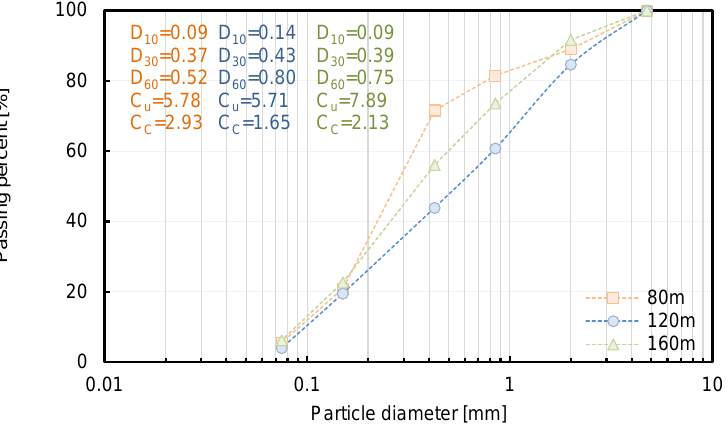
Figure 2. Results of sieve analysis. The D 10 , D 30 , and D 60 denote the particle diameter corresponding to 10 [%], 30 [%], and 60 [%] passing percent. The coefficients of uniformity (C u ) and curvature (C c ) can be calculated for D 60 /D 10 and D 302 /D 60 D 100 , respectively.